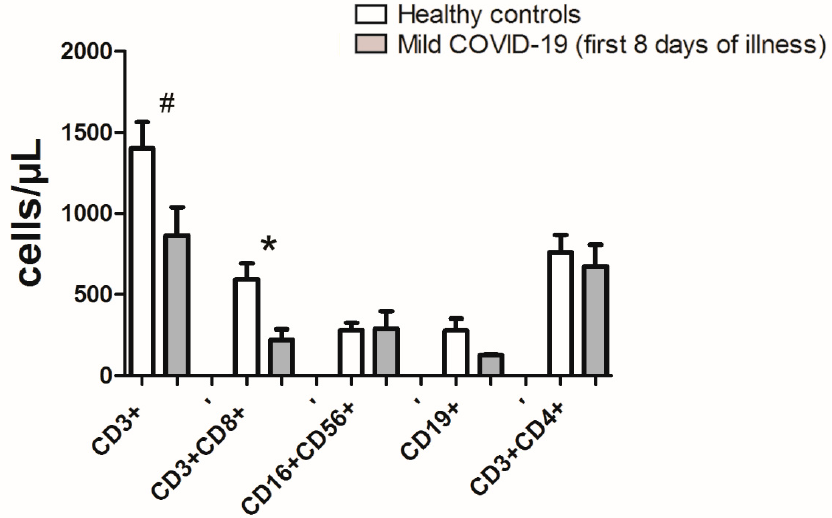
Figure 2. Absolute count of CD3+, CD3+CD8+, CD16+CD56+, CD19+, and CD3+CD4+ in healthy controls and mild COVID-19 patients within first eight days of illness. Data is presented as mean value ± standard deviation. Significant differences are indicated by p * = 0.01, p # = 0.05 (unpaired t test with Welch’s